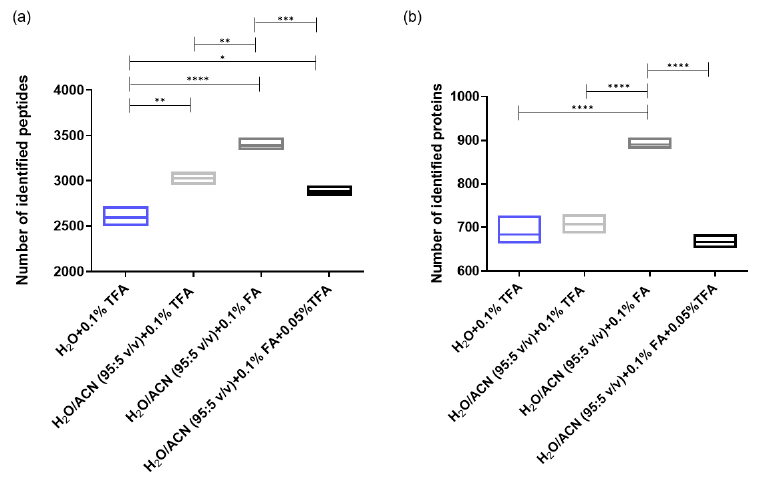
Figure 3. ( a ) Number of peptides identified with different resuspending solvents; ( b ) Number of proteins identified with the different resuspending solvents. Line at mean and boxes from min to max ( n = 3). * represents p -value < 0.05; ** ( p -value < 0.01); *** ( p -values < 0.001) and **** ( p -value < 0.0001). Sample: 1 µg Pierce™ HeLa Protein Digest Standard.